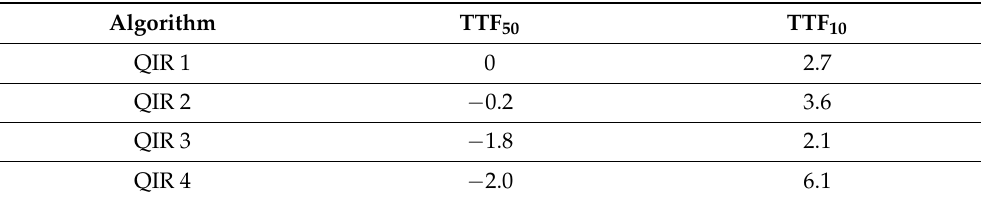
Figure 2. High contrast TTF as a function of image reconstruction. Graphs show TTF for a high- contrast task (PTFE—Polytetrafluoroethylene) as a function of spatial frequency among reconstruc- tions. A slight shift towards lower frequencies was observed with increasing QIR level indicating slightly decreased spatial resolution. Table 1. High-contrast TTF 50 and TTF 10 frequency shifts in percentage differences for QIR-1 to 4 levels in comparison with